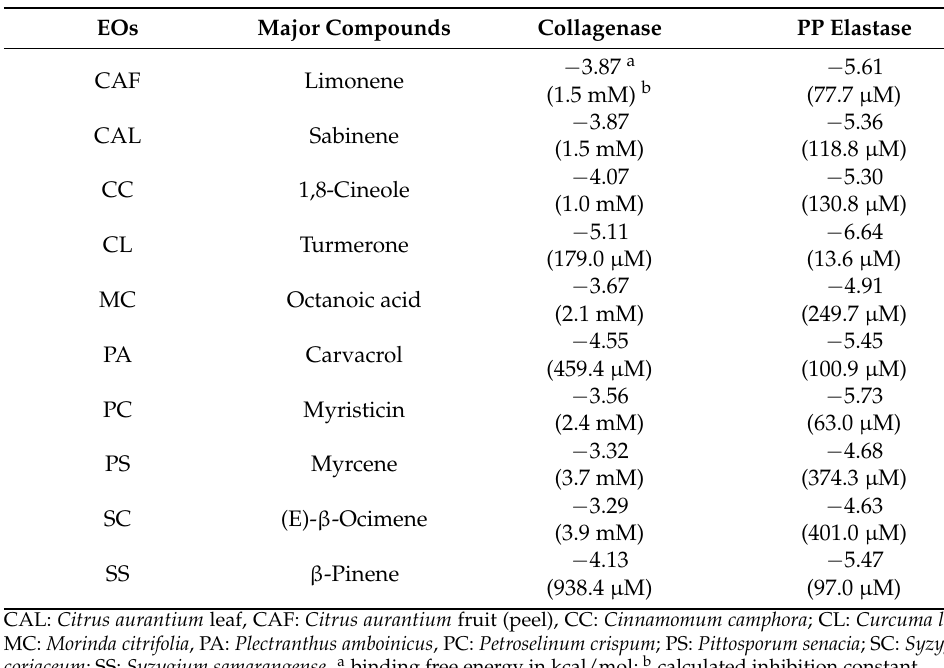
Table 4. Docking scores of EOs compounds with target enzymes.